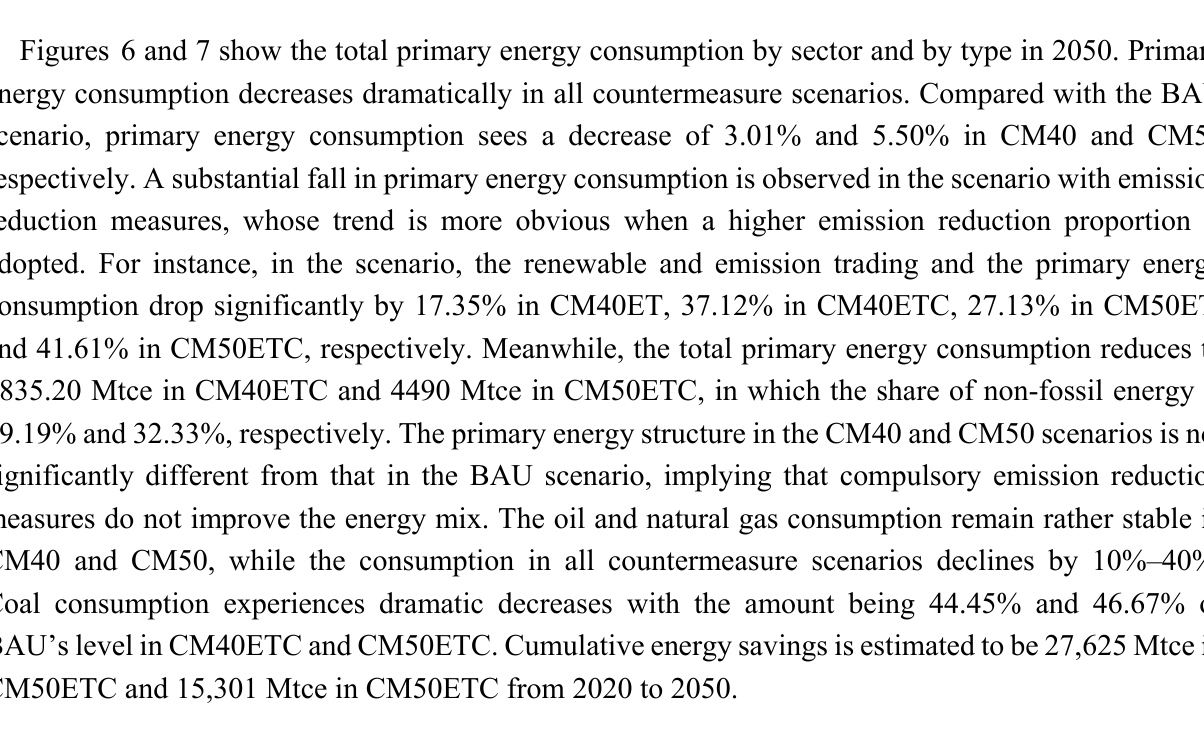
Figure 5. The total electricity generation mix through